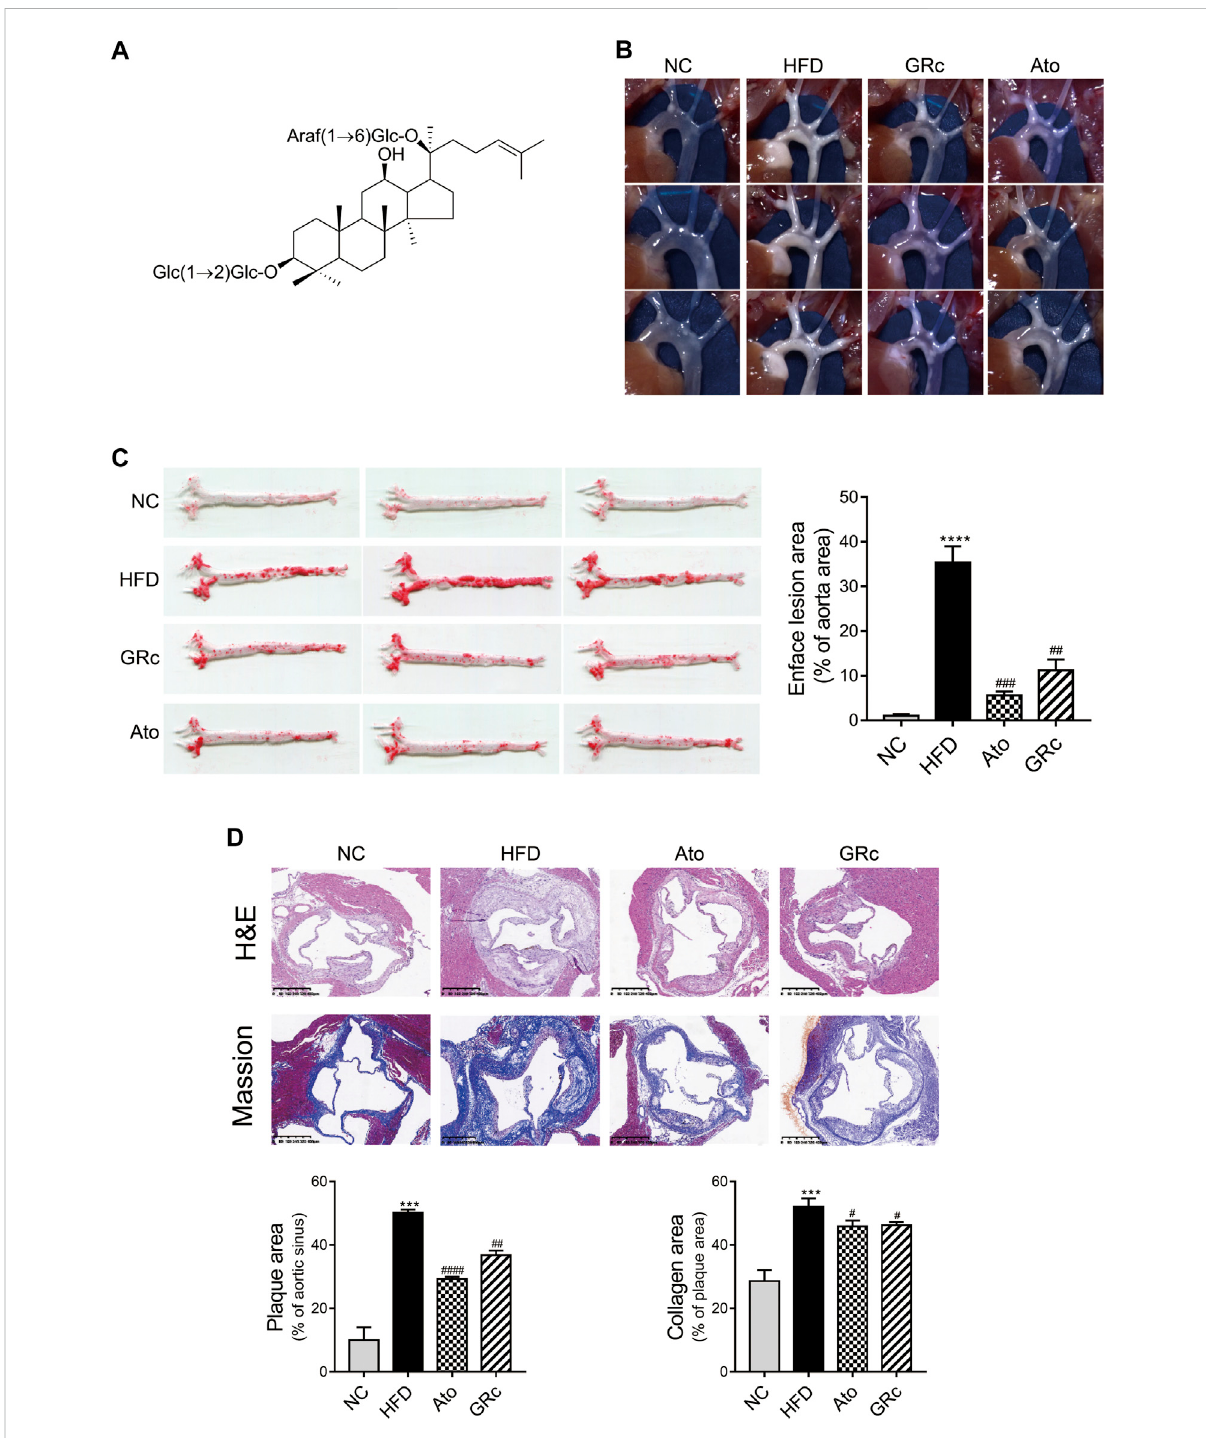
FIGURE 2 GRc alleviated atherosclerotic lesions in HFD-induced ApoE − / − mice ( n = 6). (A) Chemical structure of GRc. (B) Photographs of the aortic arch capturedusingthemicroscope. (C) RepresentativephotographsofthewholeaortabyOilRedOstaining,andtheplaqueareaofthewholeaortawas quantitated. (D) Representative images of aortic sinus sectionsby H&E staining and Masson ’ s staining; bar = 400 μ m. The lesionand collagen area in theaorticsinuswerequantitated.Thedataareexpressedasmeans±SEM.* p < 0.05,** p < 0.01,and*** p < 0.001vs.NC;# p < 0.05,## p < 0.01, and ### p < 0.001 vs. HFD. NC, normal control; HFD, high-fat diet; Ato, atorvastatin; GRc, ginsenoside